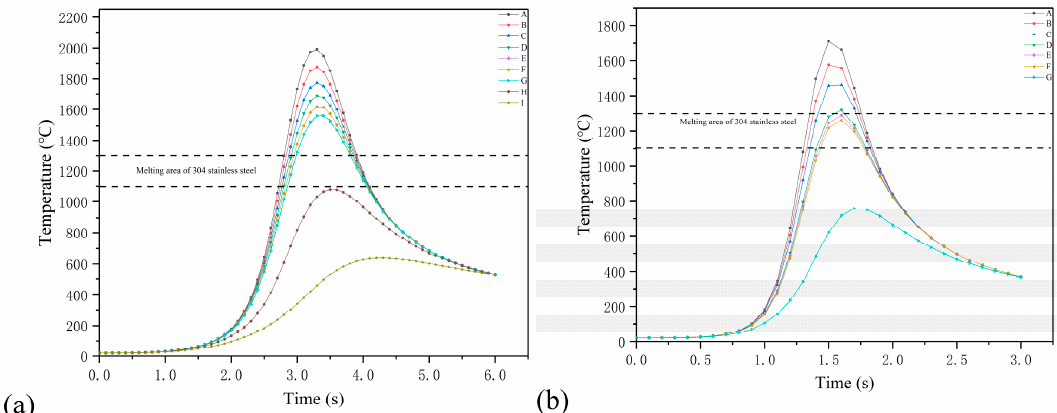
Figure 14. The time-history curves of the monitoring point in the depth direction of the molten pool: ( a ) 0.005 m/s, 1500 W; ( b ) 0.01 m/s, 1500 W.